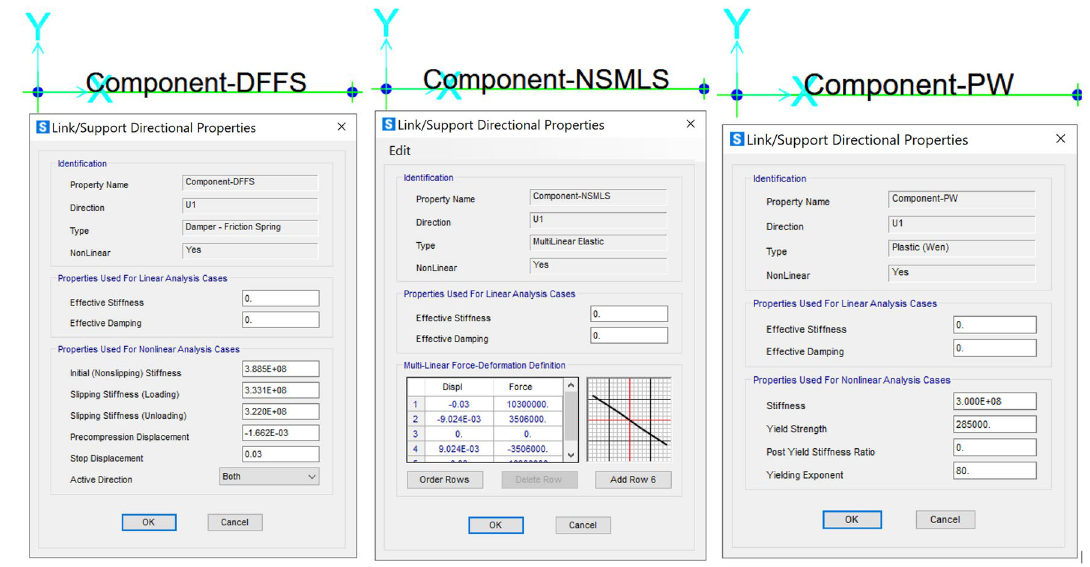
Fig. 15 User interface of defining property for 3 link components in SAP2000